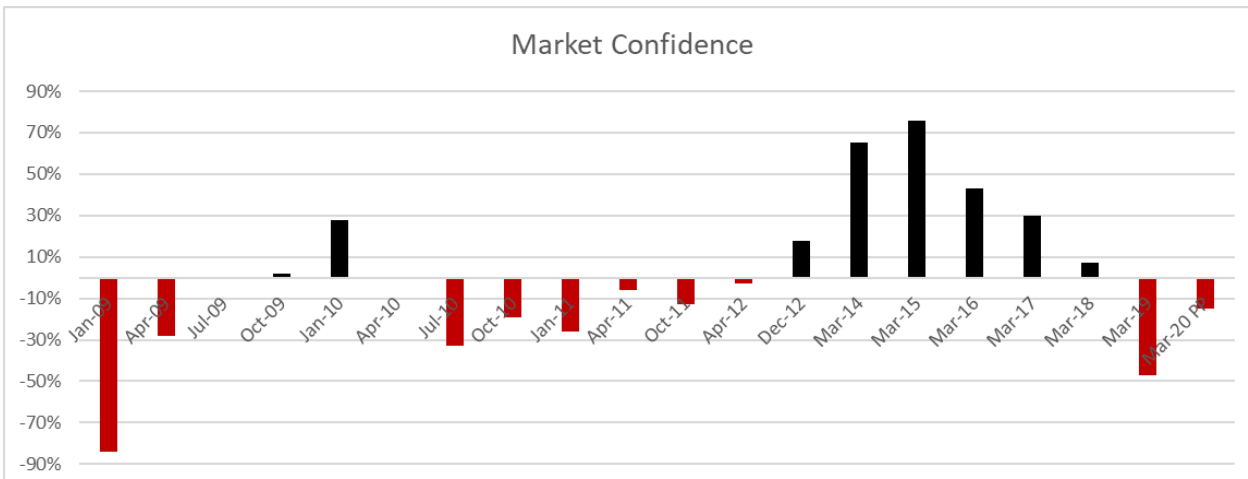
Figure 2: Market Confidence from January 2009 to March 2020. Total confidence is those that think the market won’t deteriorate minus those that